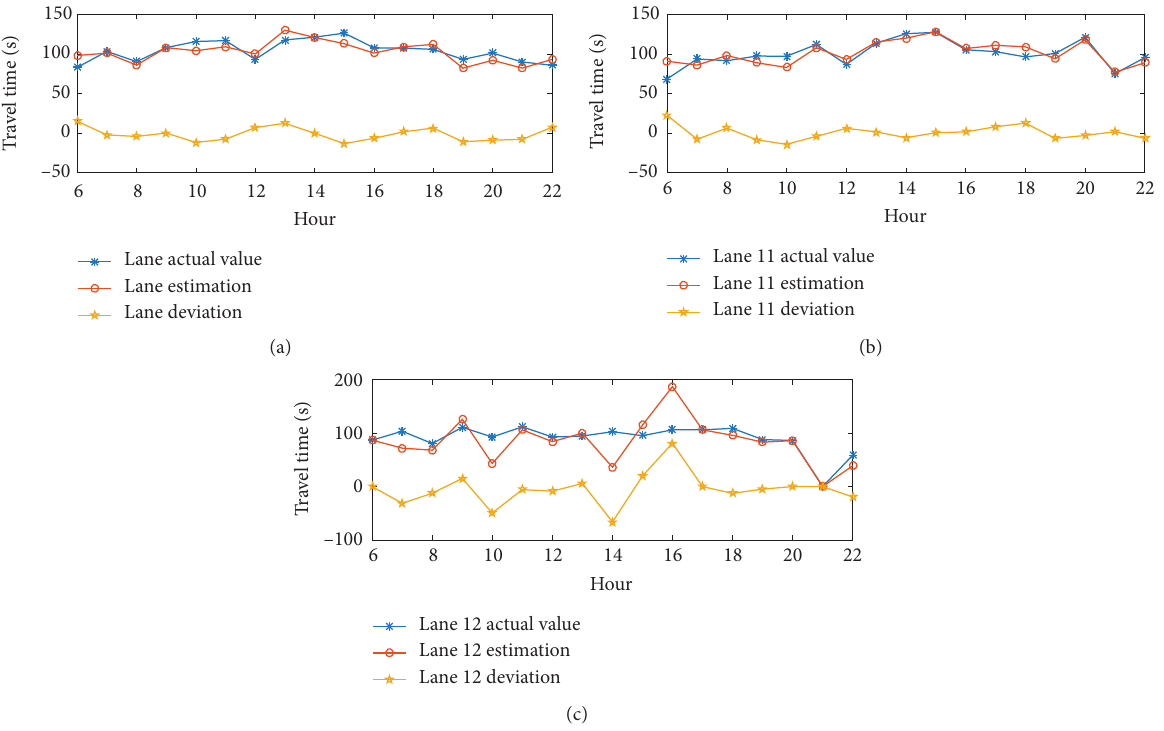
Figure 13: Lane travel time estimated based on typical vehicle random time of confidence interval on December 2,